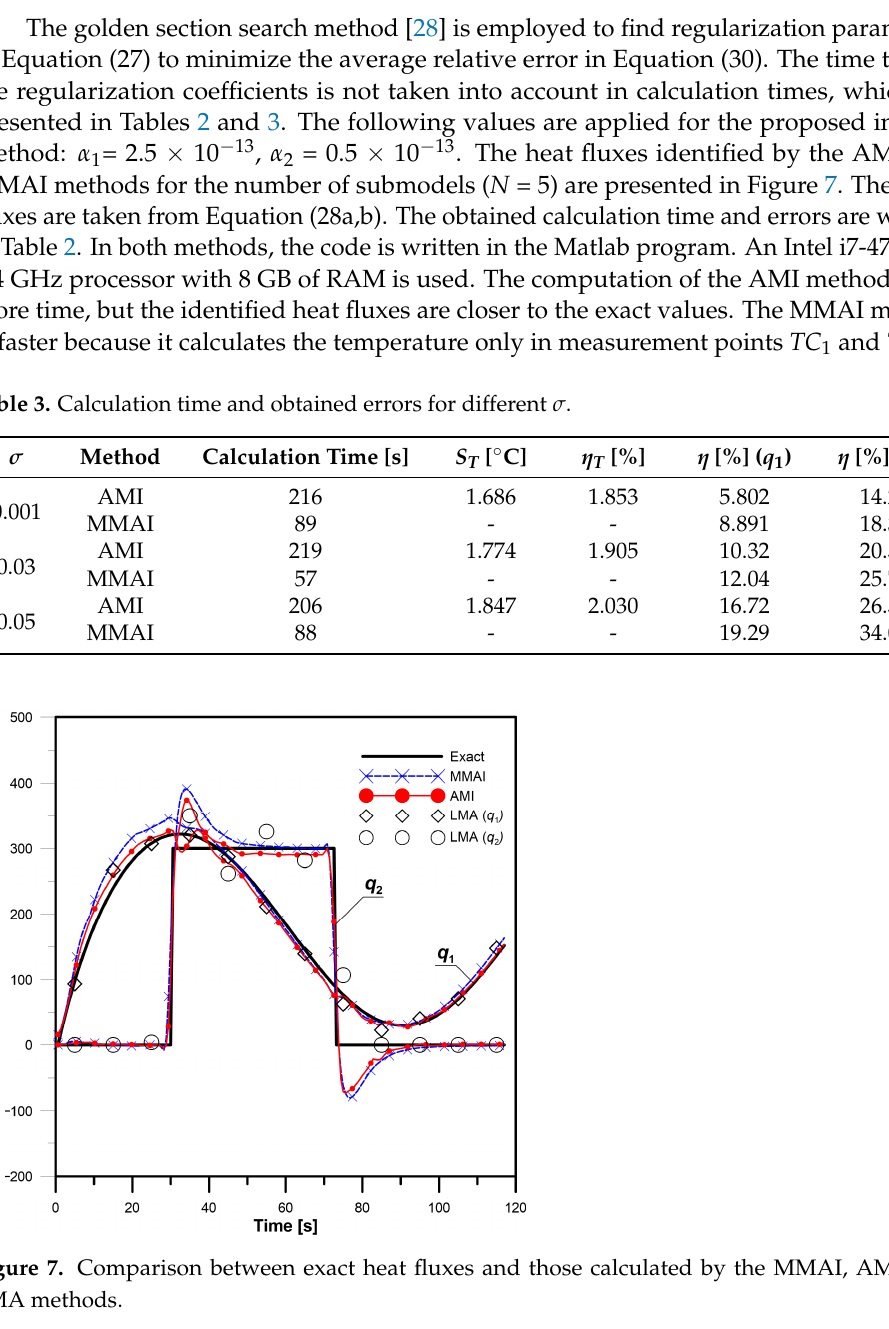
Table 2. Calculation time and obtained errors for the three methods with σ = 0.